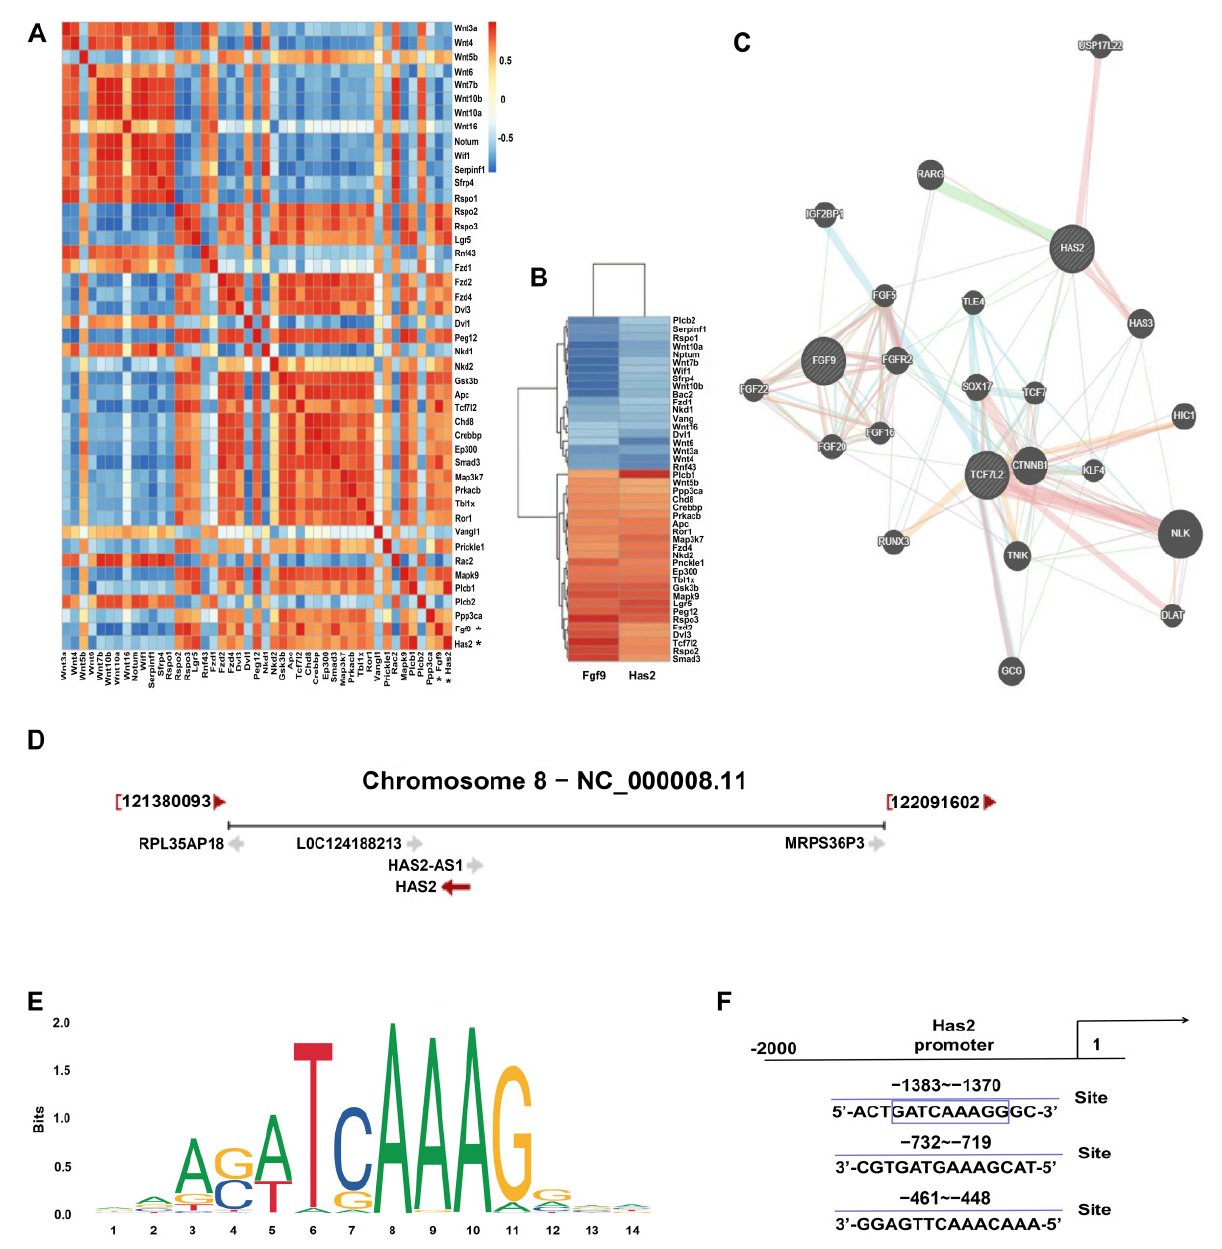
Figure 3. The correlation among FGF9, HAS2 and TCF7L2 in palate development. ( A , B ) Cluster thermography analysis of differential expression of Fgf9, Has2 and WNT/ β-catenin pathway during palatogenesis. Correlation was assessed using a Pearson’s correlations test. ( C ) Analysis of FGF9 and HAS2 co-expressed genes through the genemania database. ( D ) Mice Has2 promoter information was obtained from NCBI. ( E ) The DNA motif for TCF7L2 was obtained from JASPAR. ( F ) TCF7L2 binding sites in Has2 promoter were predicted by JASPAR.